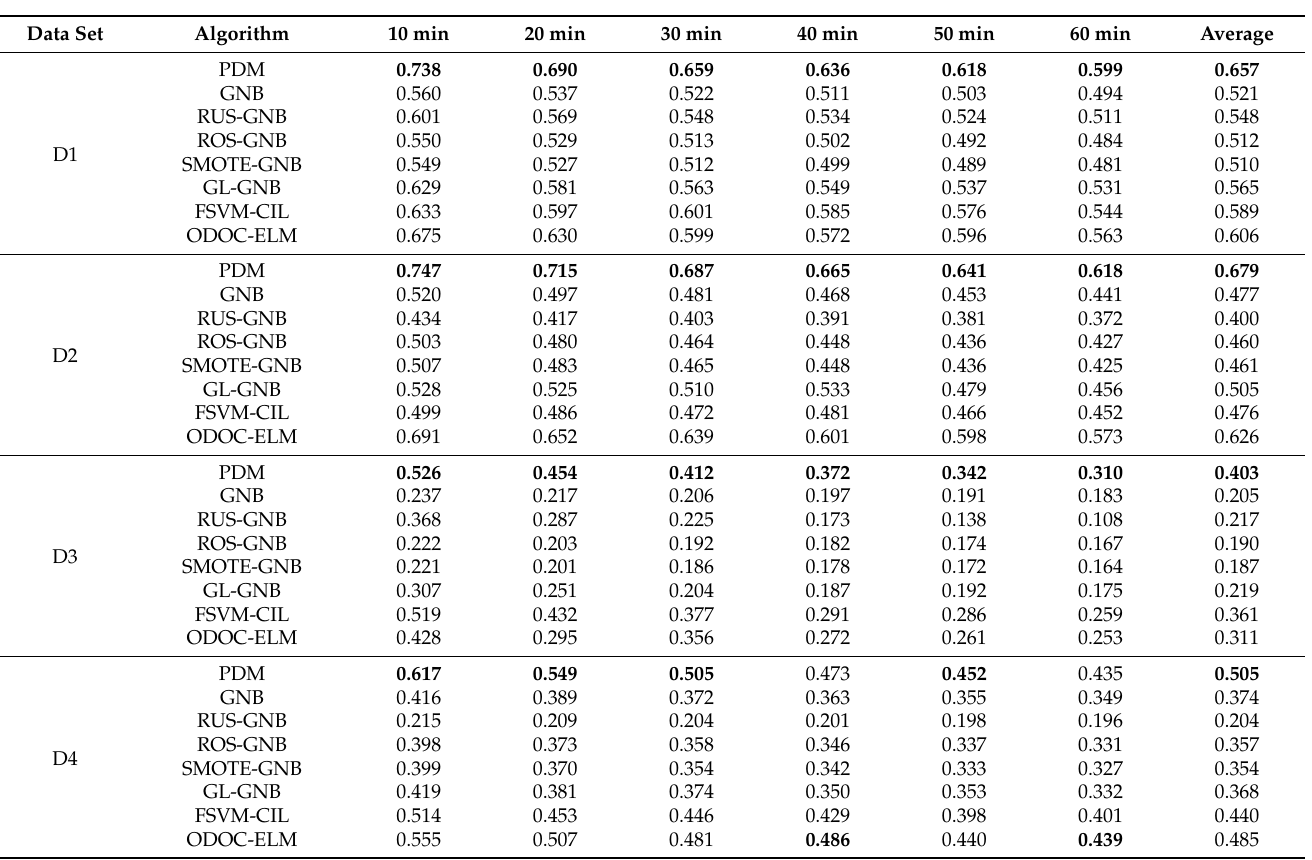
Table 2. F-Measure of future one-hour early warning results of each algorithm on six data sets, where the best result is highlighted in